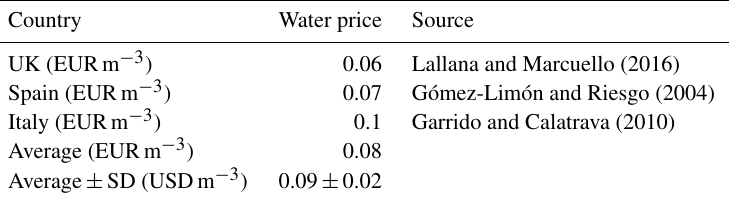
Table E1. Cost of